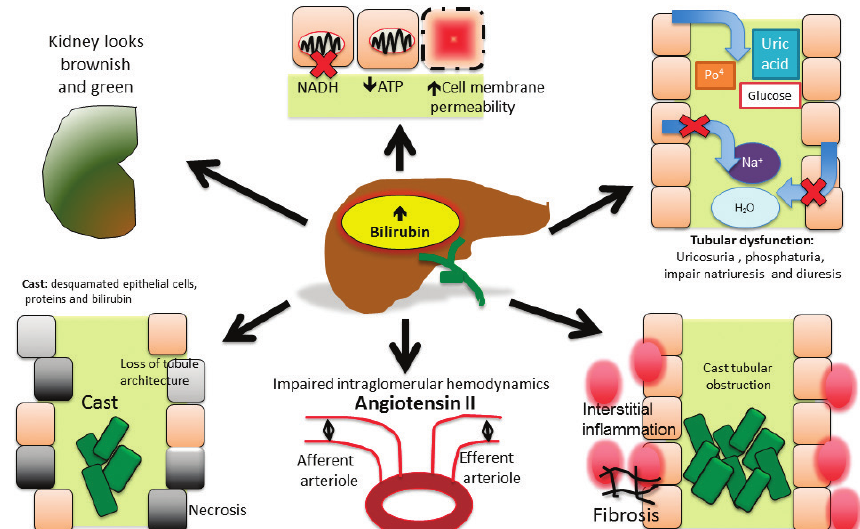
Figure 1. Interactions between hyperbilirubinemia and kidney. Macroscopically, the kidney may look brownish or greenish. In renal tubular cells, hyperbilirubinemia affects mitochondrial function, causes phosphaturia, uricosuria, and glycosuria. Hy- perbilirubinemia also changes the tubular architecture with necrosis and apoptosis, modulates the tonicity of the afferent and efferent arteriole, and, through the formation of casts, it generates obstruction and tubulointerstitial